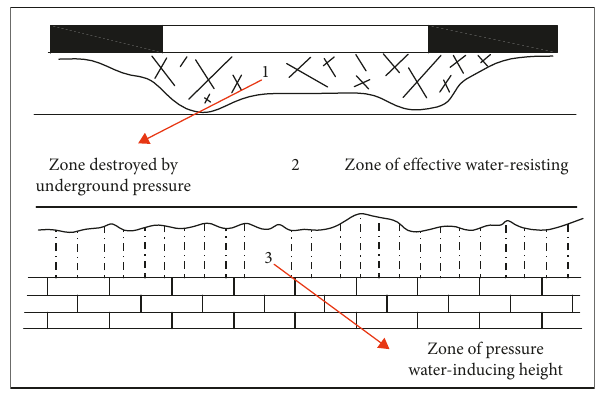
Figure 1: Schematic diagram of the Three Underlying Belts